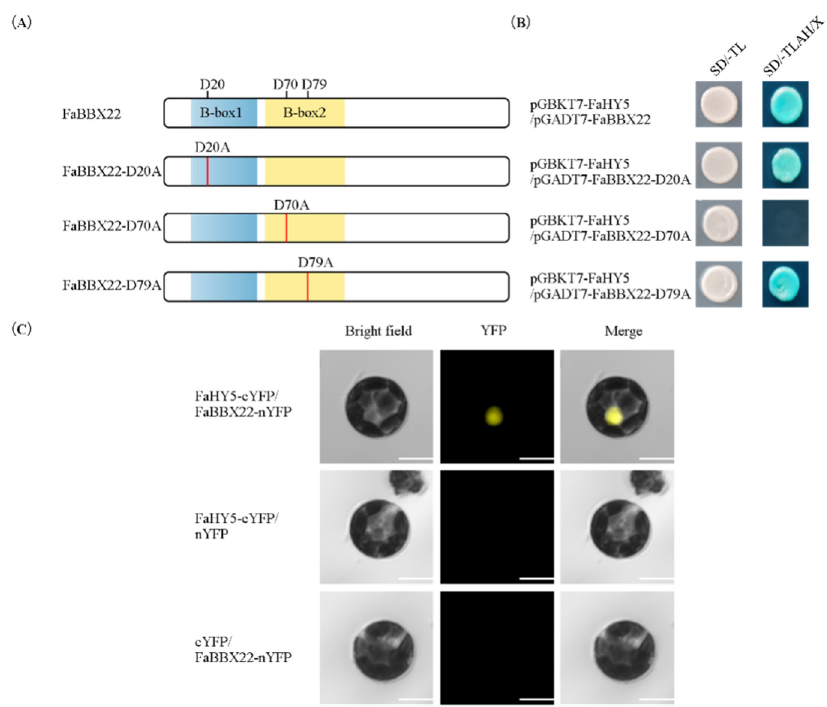
Figure 6. The physical interactions of FaBBX22 and FaHY5. ( A ) Schematic diagram of FaBBX22 domains and its mutations; ( B ) Yeast two-hybrid assays of FaBBX22 and FaHY5. SD/-TL indicates SD/-Trp-Leu medium, SD/-TLAH/X indicates SD/-Trp-Leu-Ade-His/X- α -gal medium with 100 ng/mL Aureobasidin A; ( C ) Bimolecular fluorescence complementation assays of FaBBX22 and FaHY5. Bars, 10 μ m.